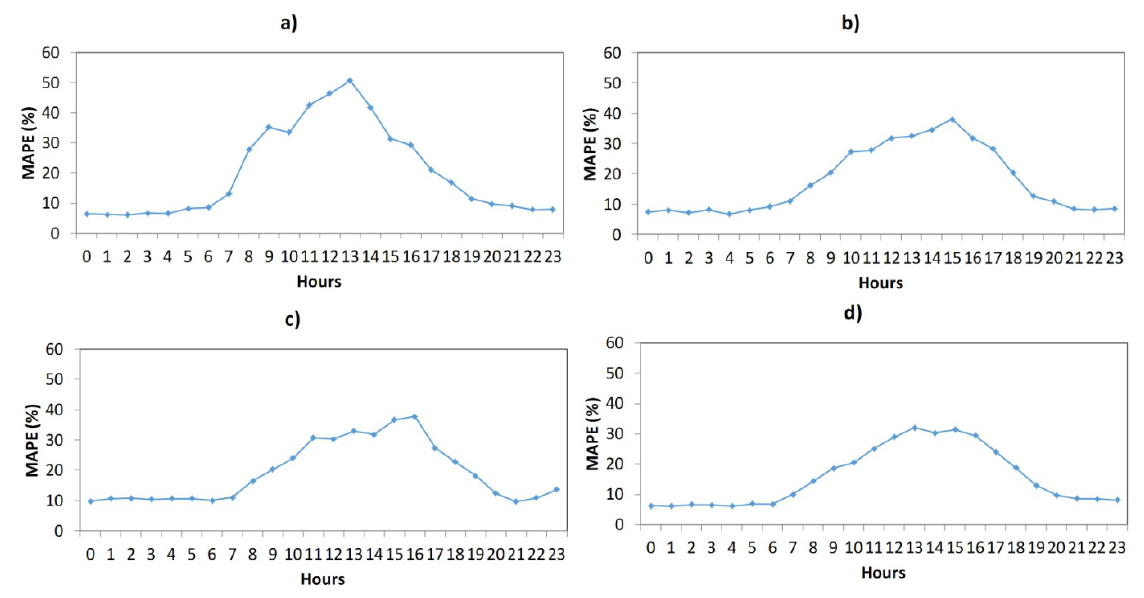
Figure 7. Hourly Average MAPE (%) (3) of the winning architecture (all models): ( a ) F_L (19 neurons, traincgp ); ( b ) F_L_W (21 neurons, traincgp ); ( c ) F_L_W_DW (21 neurons, traincgb ); ( d ) F_L_W_M (21 neurons , trainbr